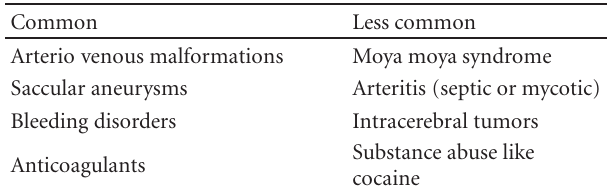
Table 2: Causes of stroke in young-Hemorrhagic.